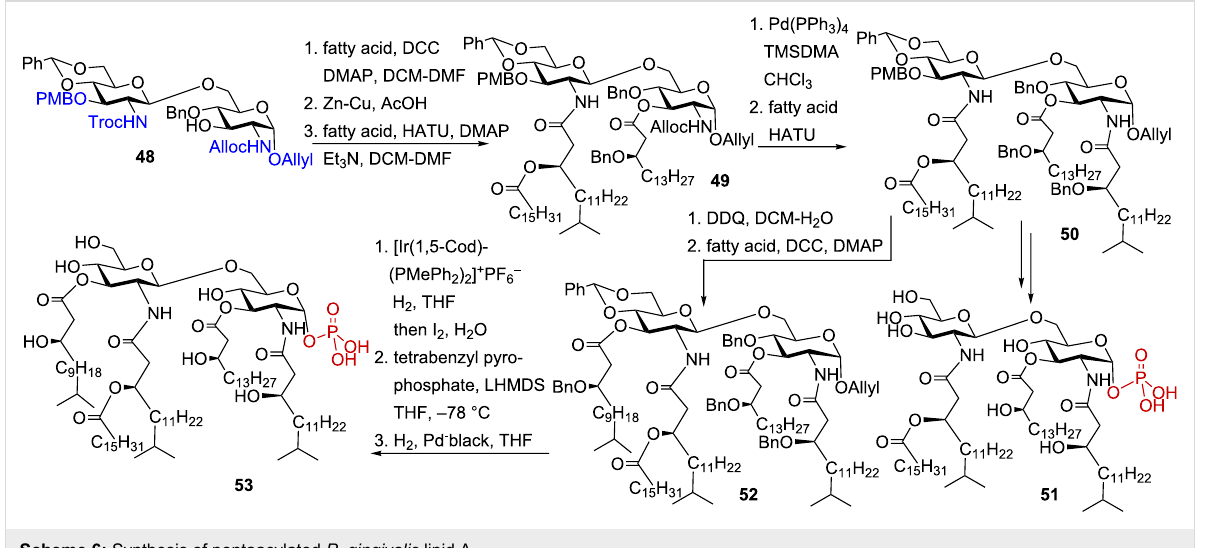
Scheme 6: Synthesis of pentaacylated P. gingivalis lipid